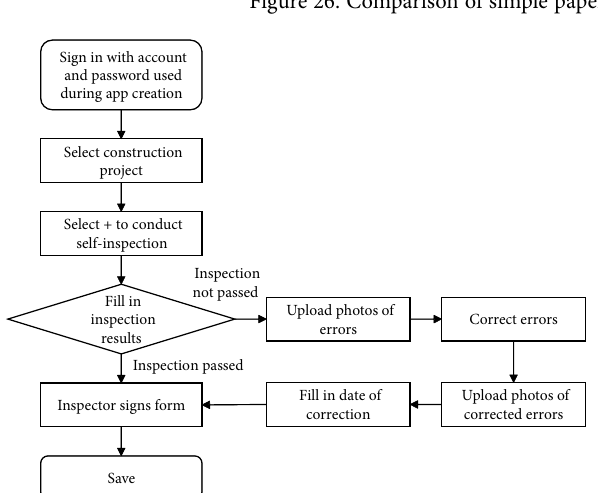
Figure 26. Comparison of simple paper checklist and operation interface in app